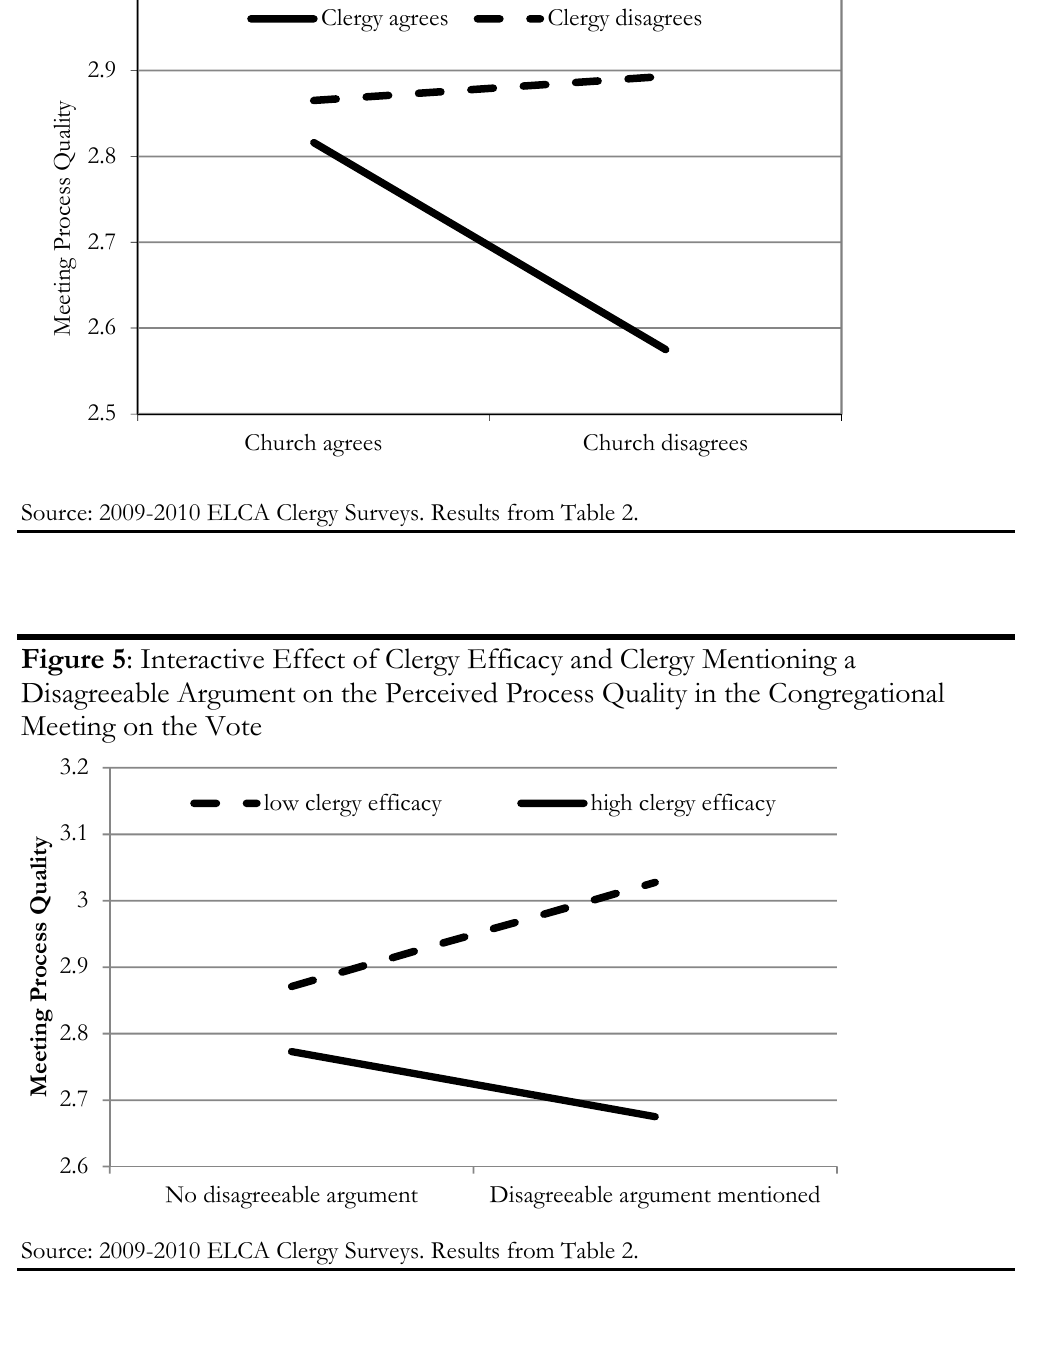
Figure 4 : Interactive Effect of Clergy and Congregational Stance on the Vote on the Process Quality in the Congregational Meeting on the Vote